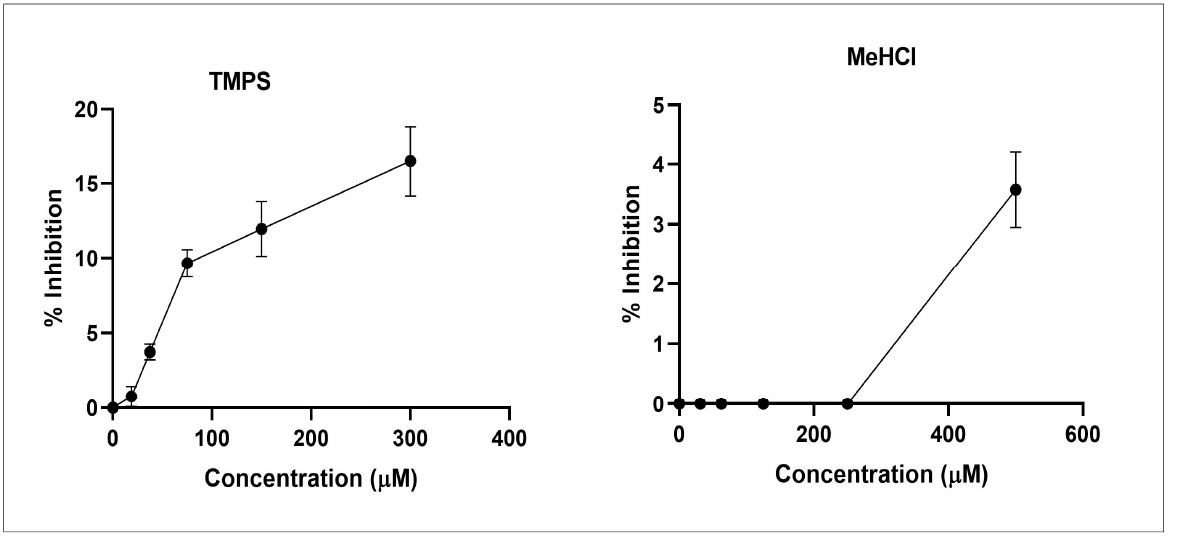
Figure 2. Amyloid- β anti-aggregation assay (data points represented as mean ± SD, where n = 3 and p < 0.05).